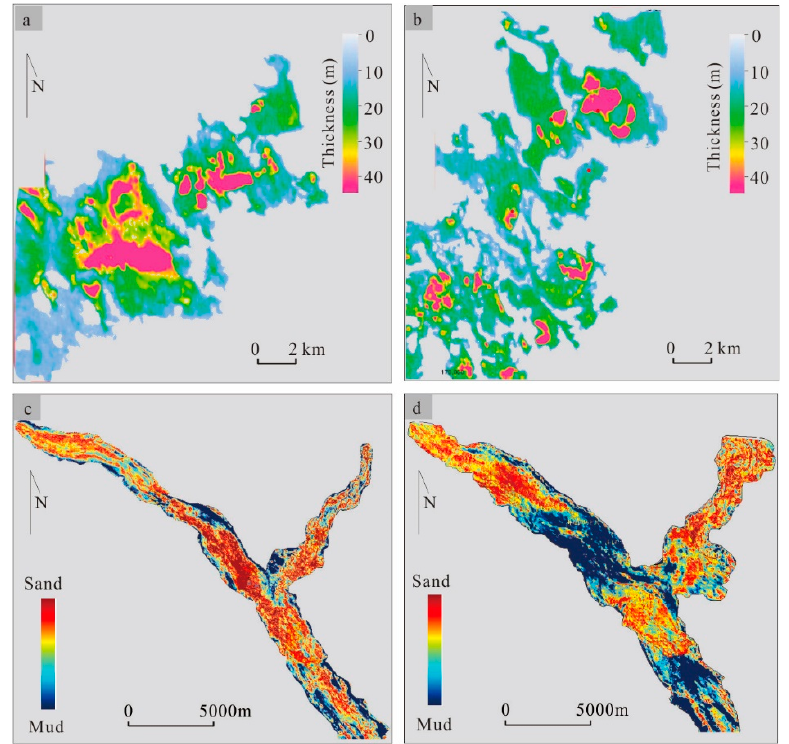
Figure 7. Thickness maps and instantaneous amplitude maps: ( a ) Thickness map of the Dongfang submarine fan developed in the first stage. ( b ) Thickness map of the Dongfang submarine fan developed in the second stage. ( c ) Instantaneous amplitude map of the Ledong submarine channel developed in the first stage. ( d ) Instantaneous amplitude map of the Ledong submarine channel developed in the second stage.